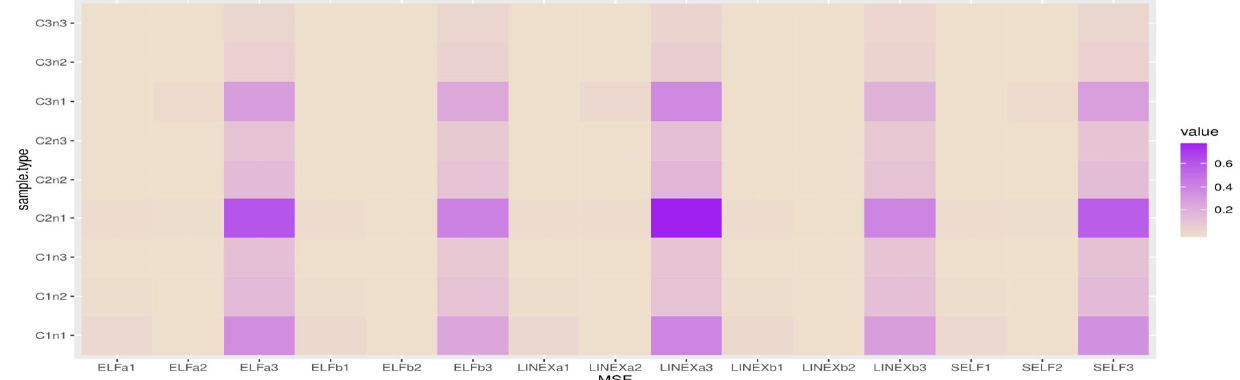
Figure 6. Heatmap for MSE when a = 2, b = 0.6.